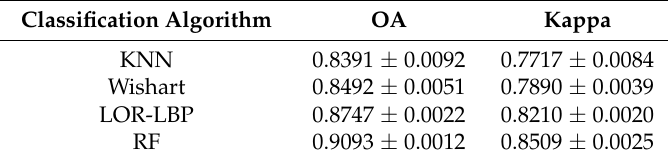
Table 5. Classification results for the UAVSAR imagery with different classification